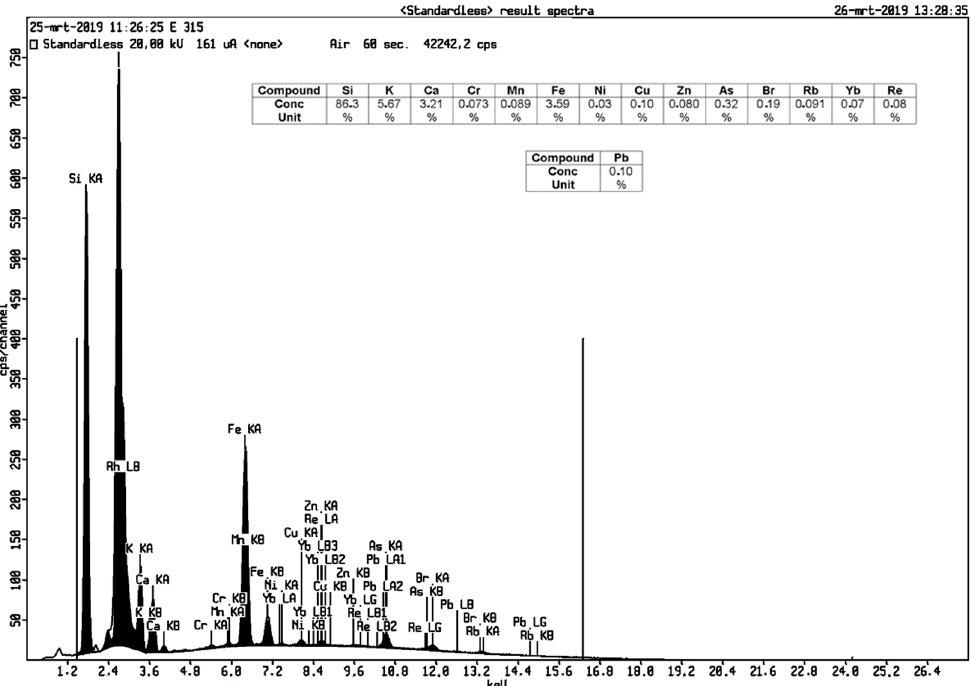
Figure 1. XRF analysis of geothermal silica before acid leaching.